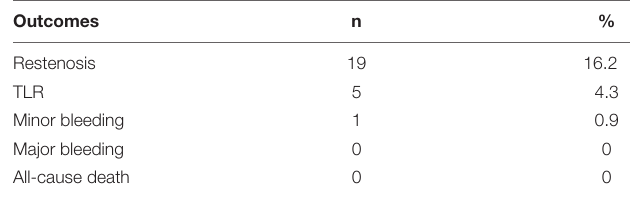
TABLE 2 | 1-year follow-up outcomes after